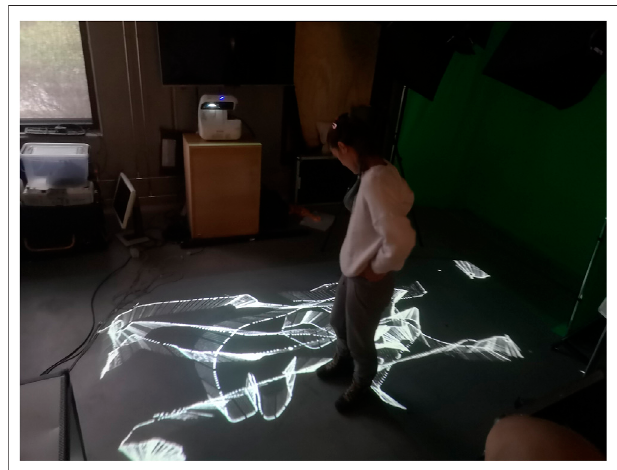
FIGURE 7 | Interactive projections on the fl oor track the motion of the Movement trajectory traces represented with a projection on the ground.